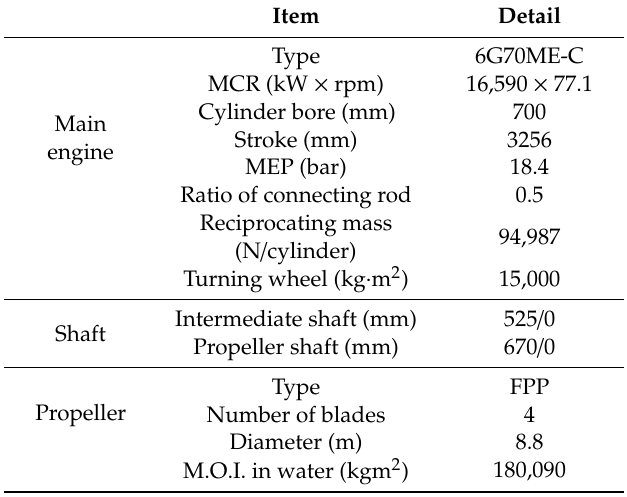
Table 1. Specification for the propulsion shafting system.